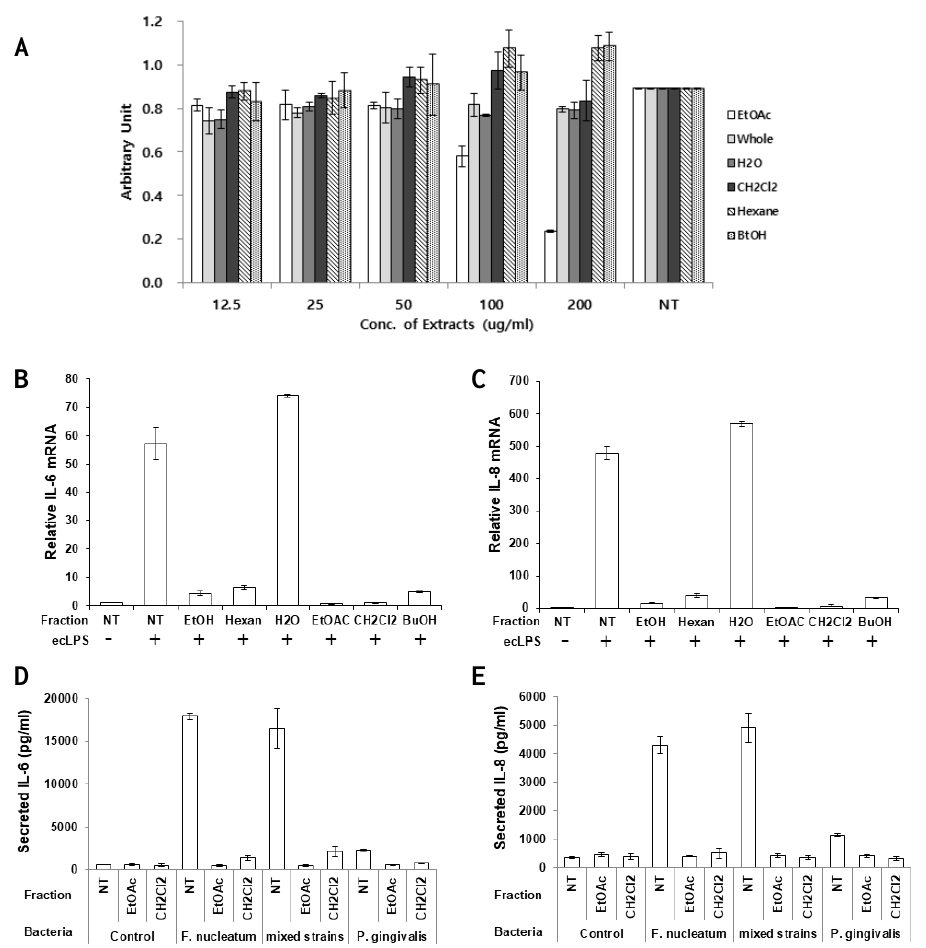
Figure 5. Inhibitory effect of the O. japonica crude extract and its fractions on pro-inflammatory cytokine expression. ( A ) Cytotoxicity of the O. japonica crude extract and its fractions. The fractions were separated as described in Materials and Methods. ( B , C ) IL-6 (B) and IL-8 ( C ) mRNA was detected after ecLPS stimulation. ( D , E ) PDLFs were infected with single strains of bacteria or their mixture, and the secretion of IL-6 ( D ) and IL-8 ( E ) was measured. The values are the mean ± standard deviation of triplicate assays. Ethyl acetate: EtOAc; Butanol: BuOH; No treatment: NT.